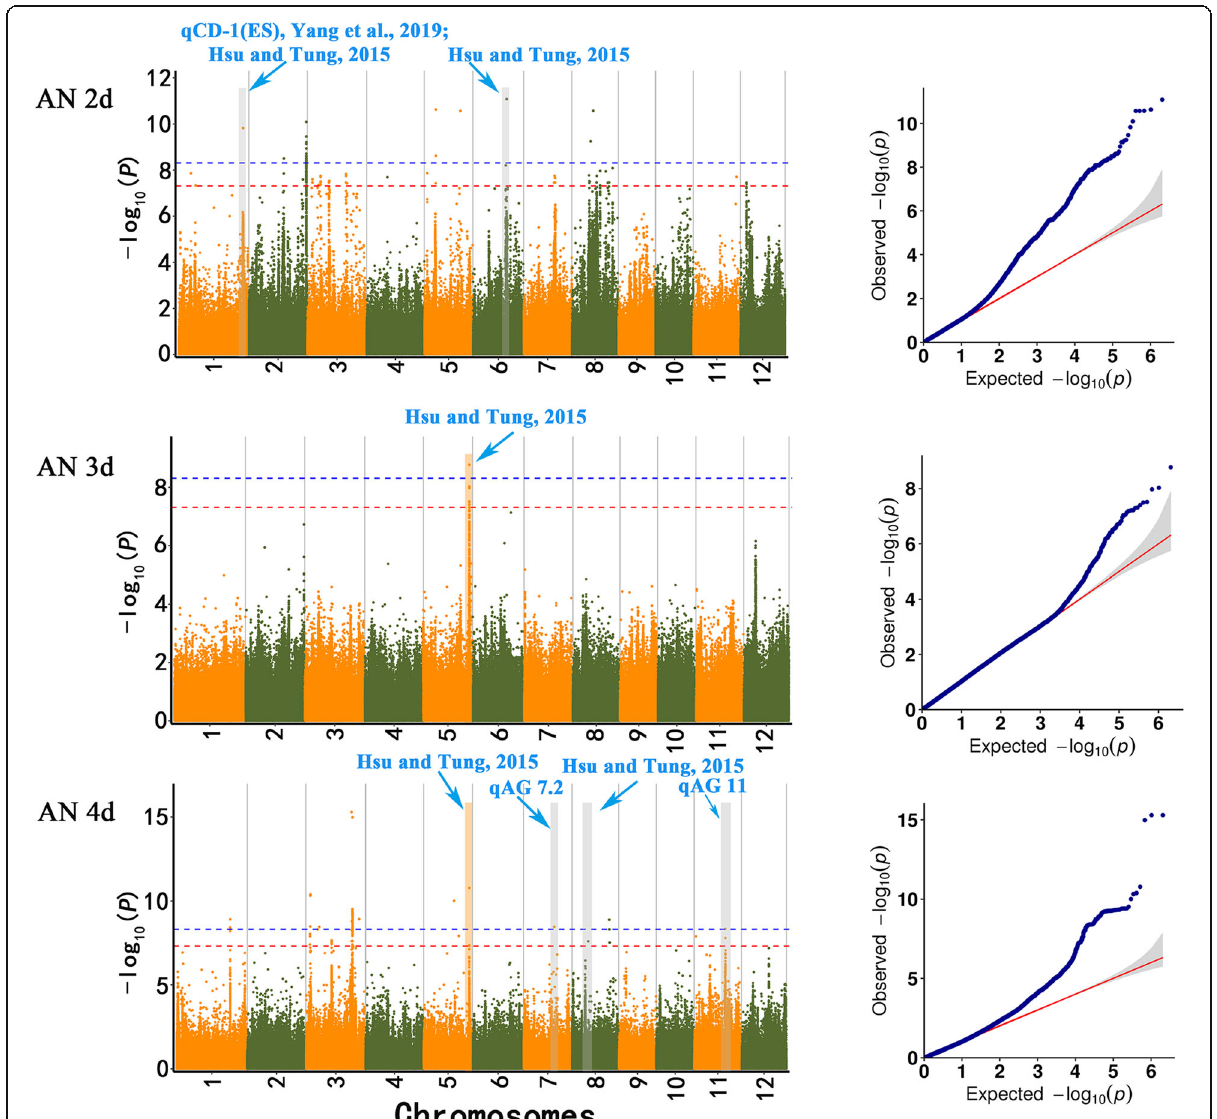
Fig. 5 Manhattan map of SNPs associated with coleoptile diameter at different time points under anaerobic germination. The red horizontal line indicates the significance threshold of multiple comparisons ( P < 0.1). The genomic regions detected in our GWAS and previous parental mapping studies were labeled as published QTLs with blue text. Orange blocks represented two co-localized genomic regions under anoxic pressure for different lengths of time in our GWAS